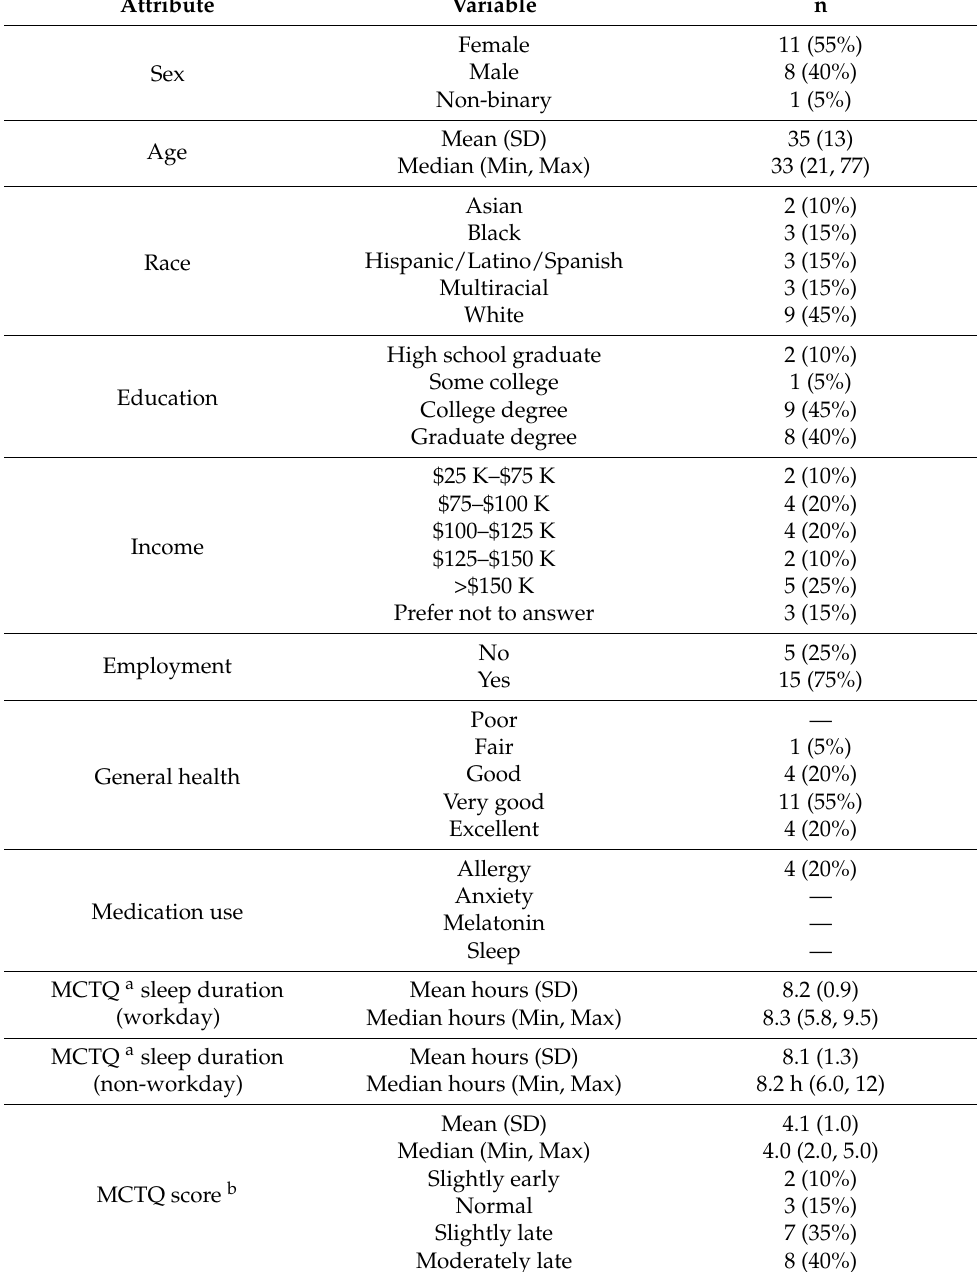
Table 1. Demographic and chronotype data collected for the 20 study